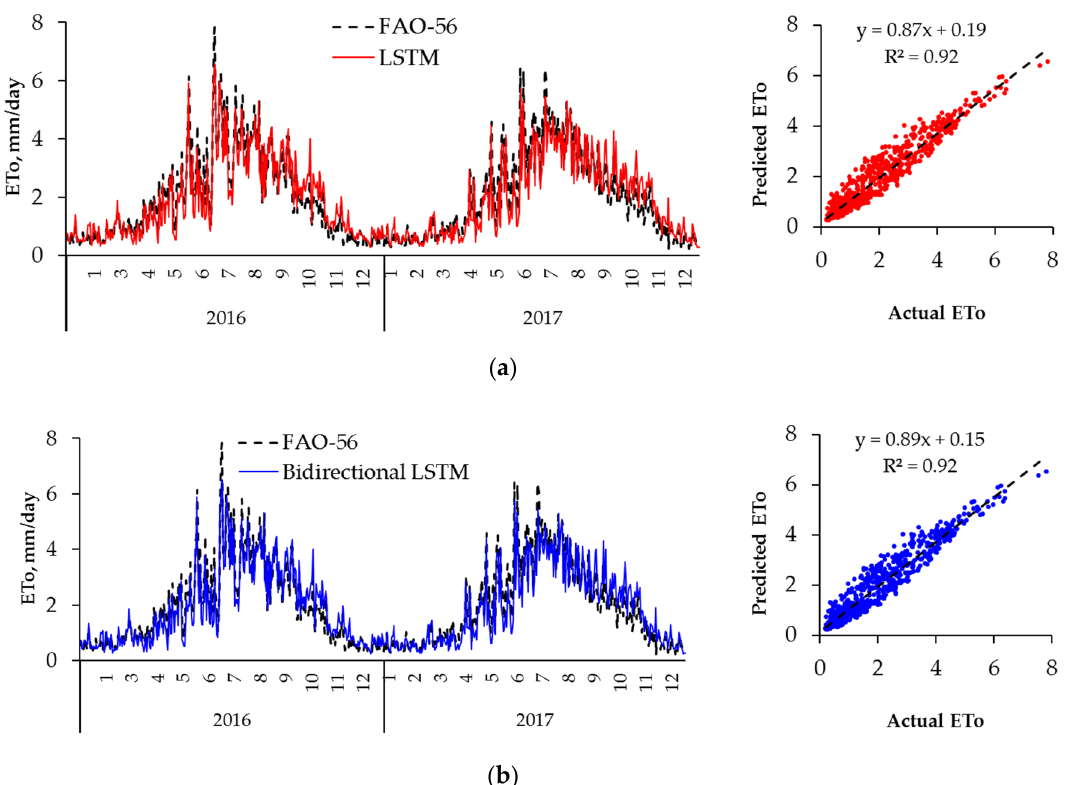
Figure 5. ( a ) Comparison of ETo predicted with LSTM and FAO-56, ( b ) with bidirectional LSTM and FAO-56 using combined data set of Prince Edward Island for the test period 2016–2017.